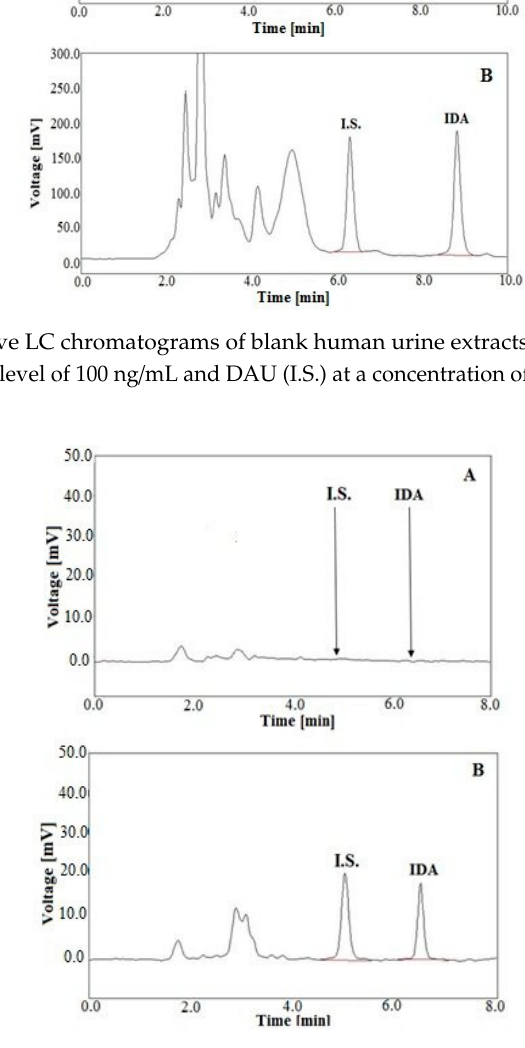
Figure 5. Representative LC chromatograms of blank human plasma extracts ( A ), a plasma sample spiked with IDA (15 ng / mL) and DAU (I.S.) at a concentration of 20 ng / mL ( B ), after SPE with HLB cartridges.